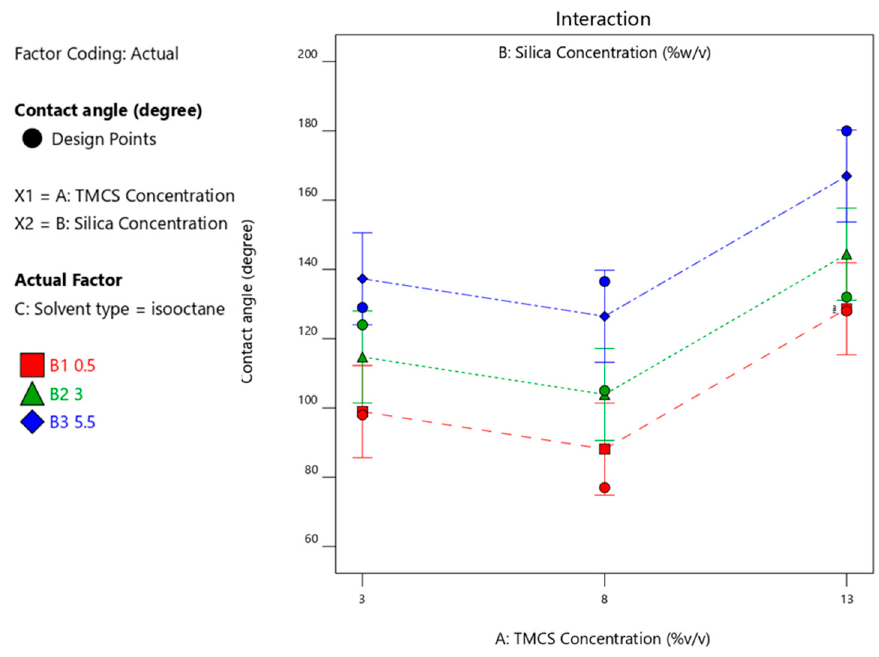
Figure 13. Contact angle upon interaction between TMCS and silica concentration with isooctane solvent.